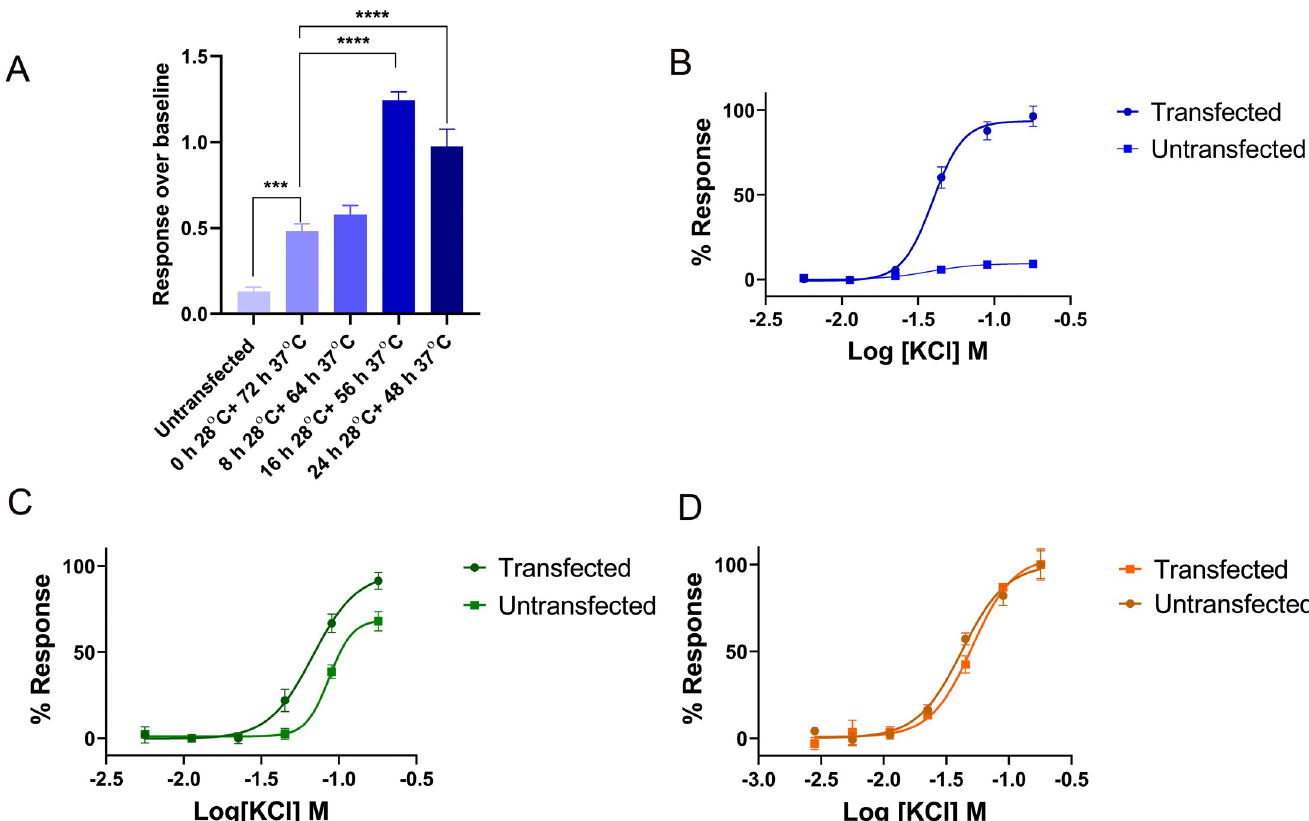
Fig 4. The optimization of transient transfection. (A) The comparison of 90 mM KCl-evoked fluorescence response from HEK293T cells transfected with Ca V 2.2, incubated in four different temperature conditions. The response over baseline from untransfected cells was 0.12 ± 0.0, which was significantly lower compared to transfected cells. The response over baseline from transfected cells incubated 72h at 37˚C, 8h at 28˚C plus 64h at 37˚C, 16h at 28˚C plus 56h at 37˚C, and 24h at 28˚C plus 48h at 37˚C were 0.5 ± 0.0, 0.6 ± 0.0, 1.2 ± 0.0, and 1.0 ± 0.1. (B) The concentration response curve of KCl-evoked Ca 2+ response from transfected and untransfected HEK 293T cells, EC 50 = 39.7 ± 0.3 mM for transfected cells. (C) The concentration response curve of KCl-evoked Ca 2+ response from transfected and untransfected COS-1 cells, EC 50 = 68.7 ± 1.2 mM for transfected cells. (D) The concentration response curve of KCl-evoked Ca 2+ response from transfected and untransfected CHO-K1 cells, EC 50 = 42.5 ± 2.2 mM for transfected cells. Transfected COS-1 and CHO-K1 cells gave similar response to the corresponding untransfected cells due to low expression level. Data are represented as mean ± SEM (N = 3 independent experiments conducted in triplicate), ��� and ���� denotes P < 0.001 and P < 0.0001,